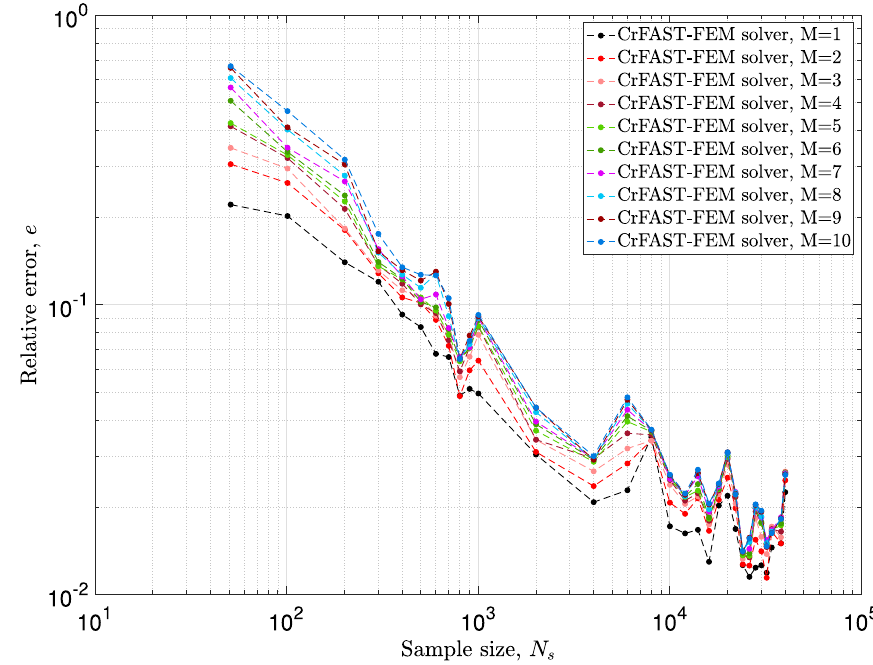
Fig. 8 The effect of the order of the harmonies, M , on the error of Eq. (39) taking into account the correction process introduced by Eq. (34)